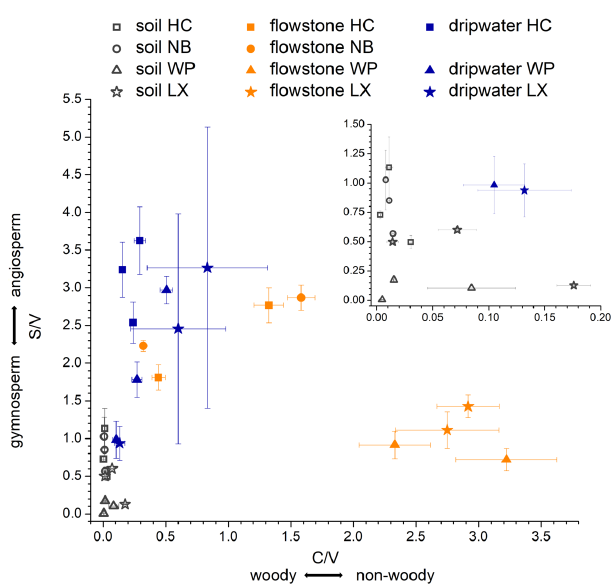
Figure 4. S / V vs. C / V values of soil, dripwater and flowstone sam- ples from Hodges Creek Cave (HC), Nettlebed Cave (NB), Waipuna Cave (WP) and Luxmore Caves (LX). The insert shows an enlarge- ment of the area close to the